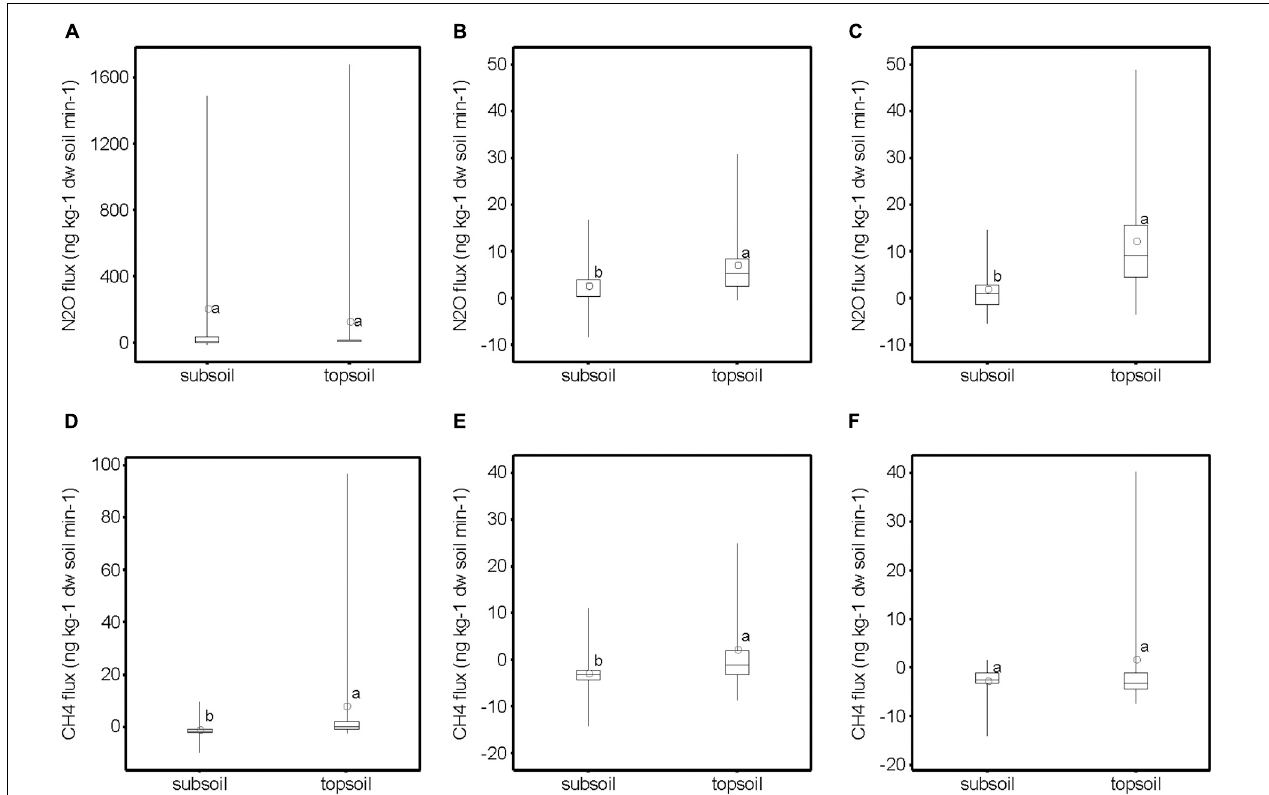
FIGURE 2 | Soil nitrous oxide (N 2 O) fluxes (ng kg − 1 dry soil min − 1 ) from topsoil and subsoil samples of soils 5–8 at (A) near water-saturated conditions, (B) 0.5 m water column, and (C) 1.0 m water column; and (D–F) methane (CH 4 ) fluxes at the respective soil water suction heads. Different subscript letters denote significantly different values of the mean (open circle, n = 28, p < 0.05). Note the different scales.